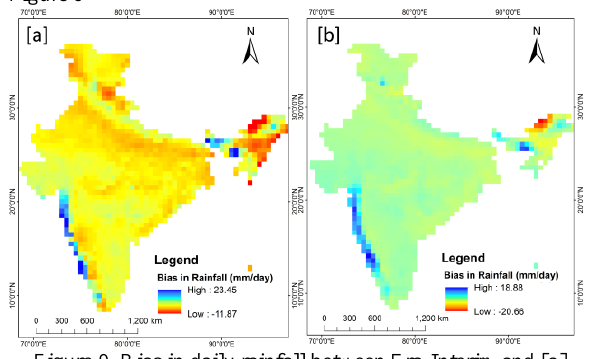
Figure 9. Scatter plot between daily rainfall in JJAS season of Era-Interim and IMD rainfall